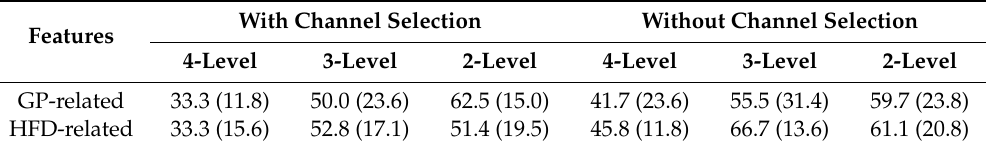
Table 7. Comparison of averaging classification accuracy (%) between GP-related and HFD-related features (in the parentheses: